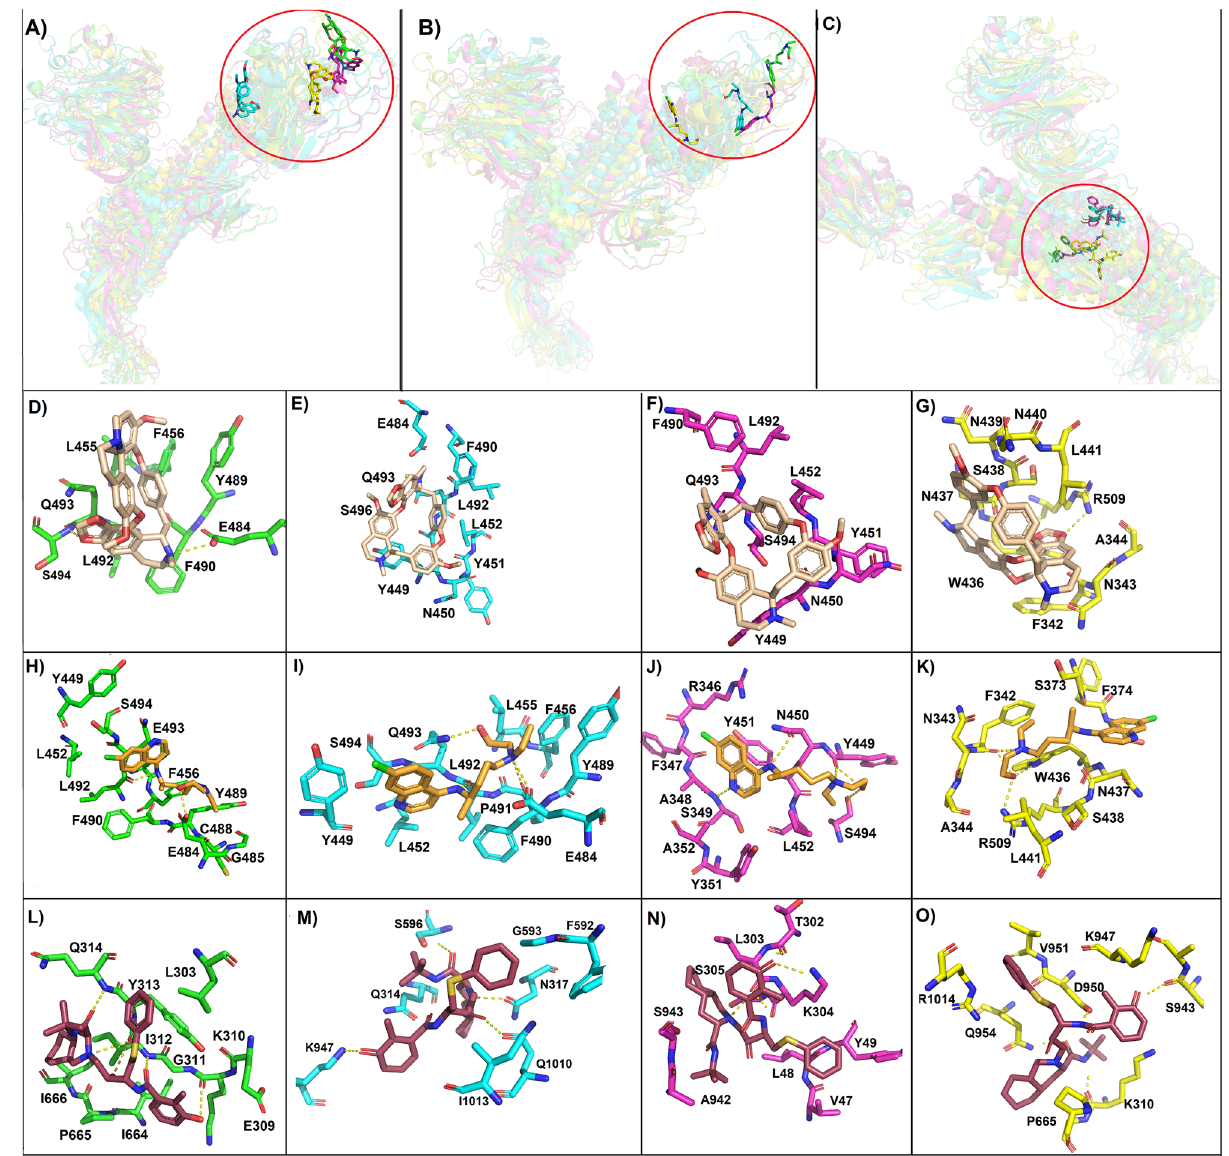
Figure 6. Molecular docking of most populated cluster conformation of spike proteins and mutants with experimentally proven compounds. General view of the binding pose obtained by docking of ( A ) cepharanthine, ( B ) hydroxychloroquine, ( C ) nelfinavir with wild type spike protein (green ribbon), D614G (cyan ribbon), H49Y (magenta ribbon) and T573I (yellow ribbon). Also, the interactions are between cepharanthine (wheat sticks) with ( D ) wild type spike protein, ( E ) D614G, ( F ) H49Y and ( G ) T573I; and hydroxychloroquine (orange sticks) with ( H ) wild type spike protein, ( I ) D614G, ( J ) H49Y and ( K ) T573I; and nelfinavir (raspberry sticks) with ( L ) wild type spike protein, ( M ) D614G, ( N ) H49Y and ( O )